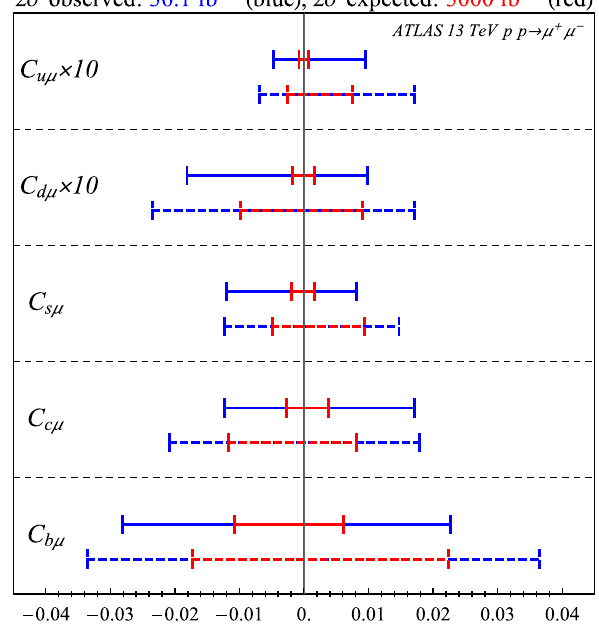
Fig. 2 In blue ( red ) we show the present (projected) 2 σ limits on C q μ (flavor conserving ( ¯ LL )( ¯ LL ) operators) where q = u , d , s , c and b , using 13 TeV ATLAS search in pp → μ + μ − channel [11]. Dashed lines show the limits when all other coefficients are marginalized, while the solid ones show the results of one-parameter